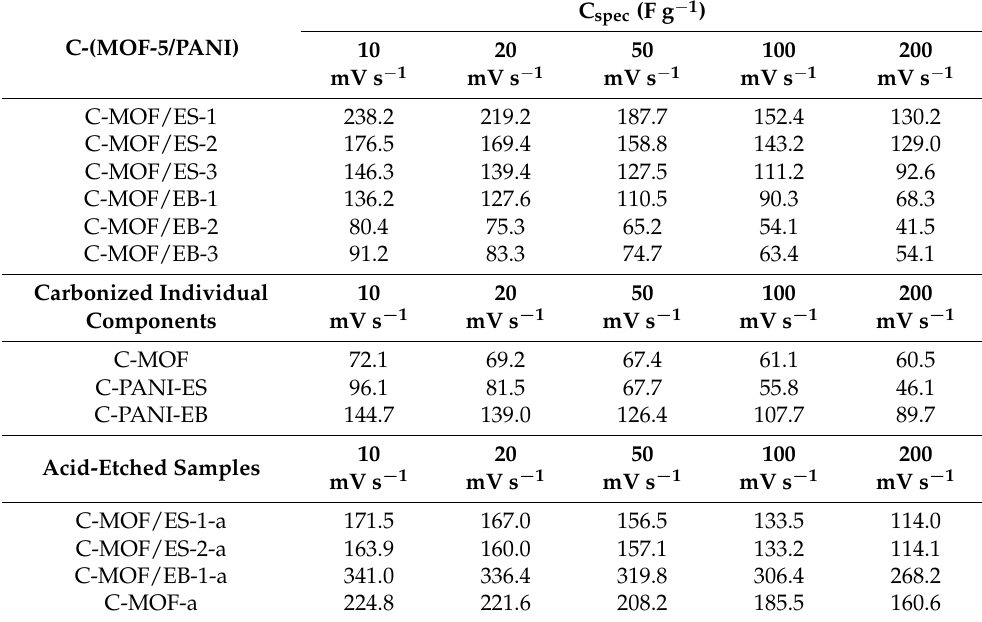
Table 5. The gravimetric specific capacitance (C spec ) of C-(MOF-5/PANI) composites, carbonized individual components, and acid-etched samples, calculated from their CVs recorded at various potential sweep rates (10–200 mV s − 1